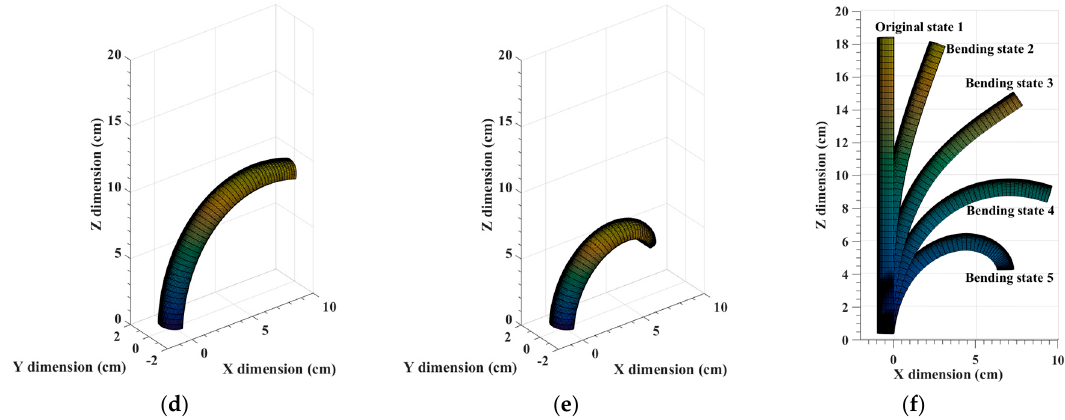
Figure 13. Shape reconstruction of the soft actuator at different bending state. ( a ) Original state 1. ( b ) Bending state 2. ( c ) Bending state 3. ( d ) Bending state 4. ( e ) Bending state 5. ( f ) Bending state 1 to 5.